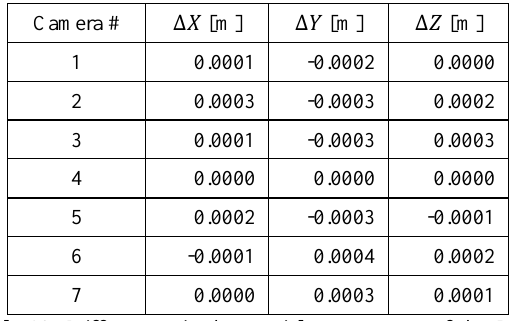
Table 13. Differences in the spatial components of the ROPs between the single-epoch minor calibration and the full major calibration